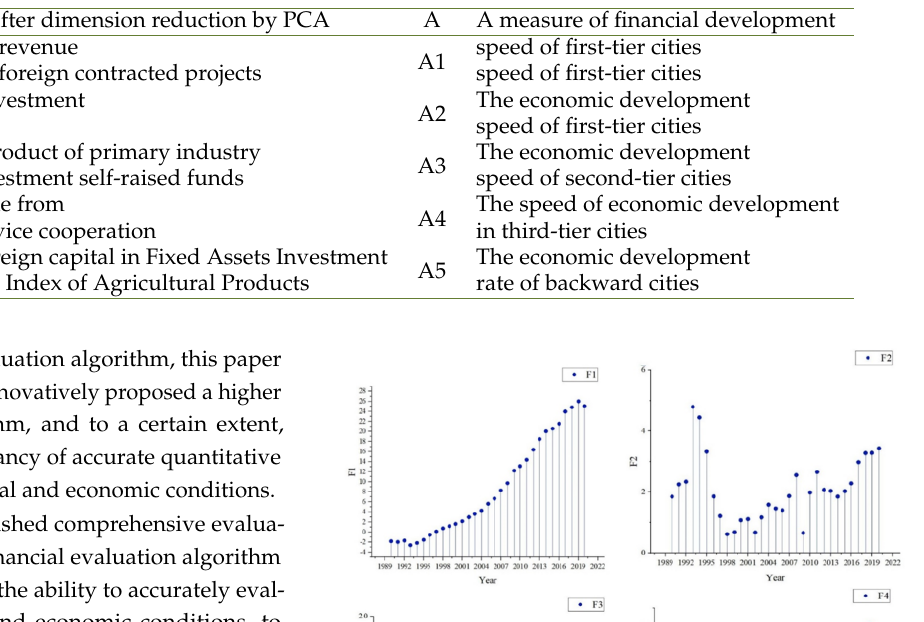
Table 2. Symbol description of PCA dimensionality reduction factors.